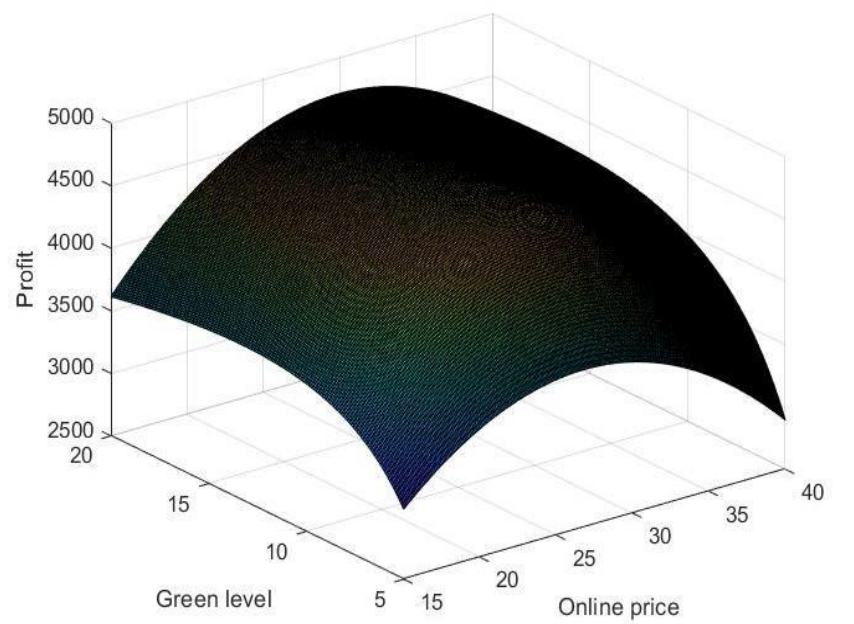
Figure 4. Graphical representation of changes of retailer’s profit with GQ and online